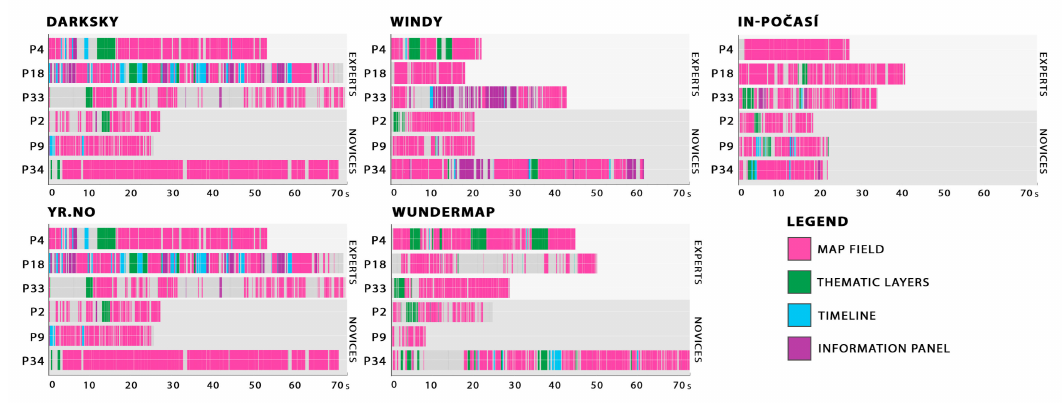
Figure 9. Areas of Interest (AOI) Sequence Chart for all evaluated maps for six selected respondents (selection of illustrative